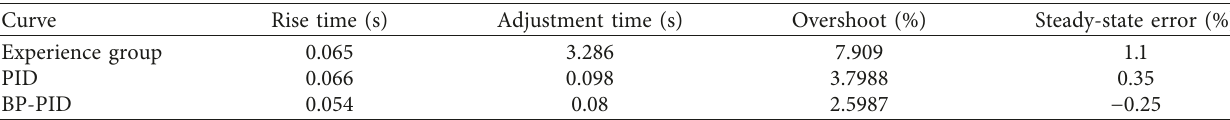
Figure 5: Firefighting robot control chart. Table 2: Performance index of step